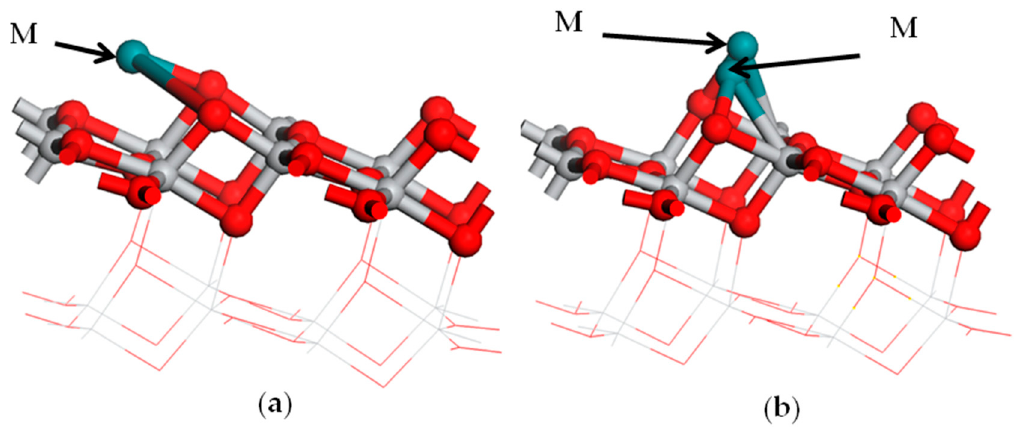
Figure 2. The structure model of the metal adsorption on the TiO 2 surface: ( a ) the monoatomic adsorption structure; ( b ) the diatomic adsorption structure. Medium shade of blue shadow, gray, and red spheres represent M of metal, Ti, and O atoms, respectively.